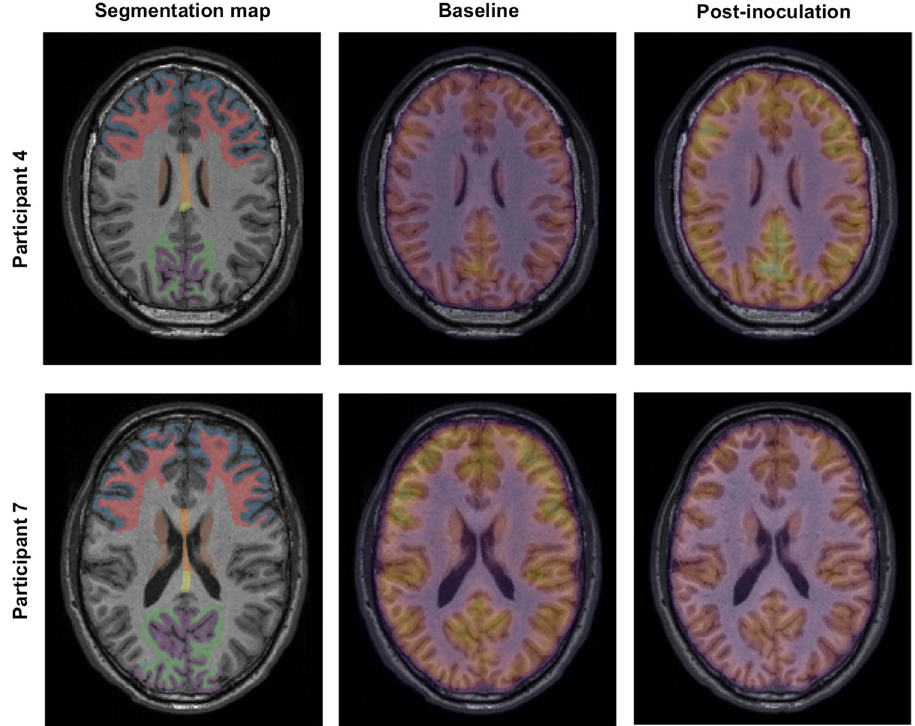
Figure 2. Example posterior subregion segmentations of T1-weighted MRI sequence (left panels), whole brain radiotracer uptake at baseline (middle panels) and post-inoculation (right panels) in Participant 4 (top row) and Participant 7 (bottom row). Segmentation map: blue—anterior grey matter; red—anterior white matter; brown—deep grey matter; yellow/orange—corpus callosum (yellow indicates splenium); purple—posterior grey matter; green—posterior white matter. Participant 4: Increased radiotracer uptake is evident globally on post-inoculation imaging. Participant 7: Decreased radiotracer uptake is evident globally on post-inoculation